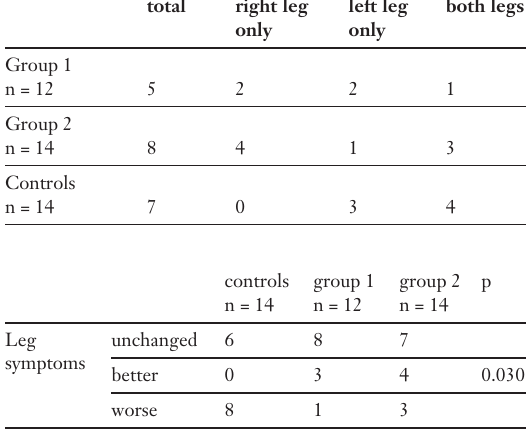
Patients ( n ) with emergent varicose veins (one week post- partum).